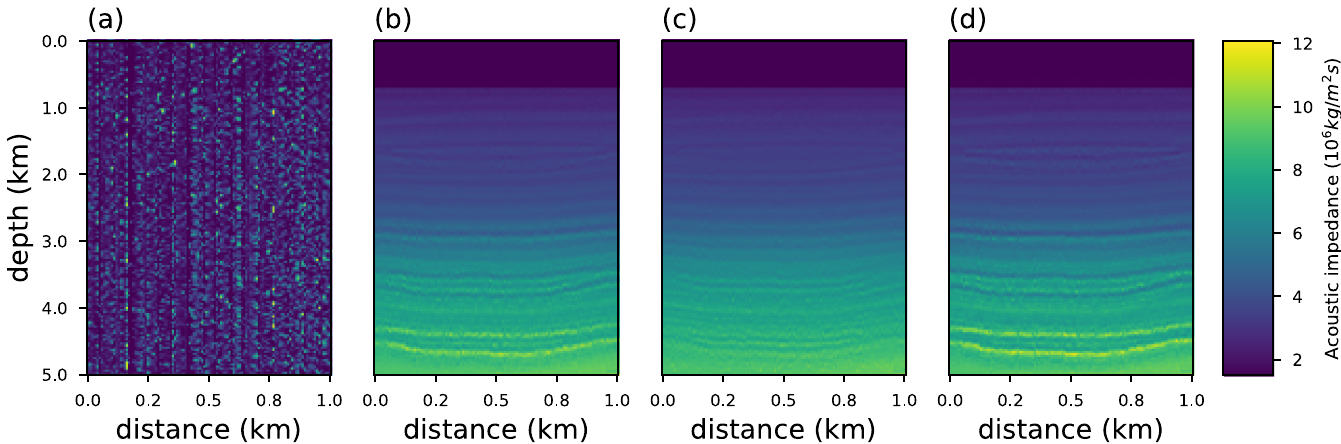
Fig 13. Acoustic impedance model recovered for an observed data contaminated with white noise (SNR = 80) and spike noise (80%) using objective function (a) conventional (b) Re´nyi with η = 0.3334; (c) Tsallis with q = 2.9999; and (d) Kaniadakis with κ = 0.6666.